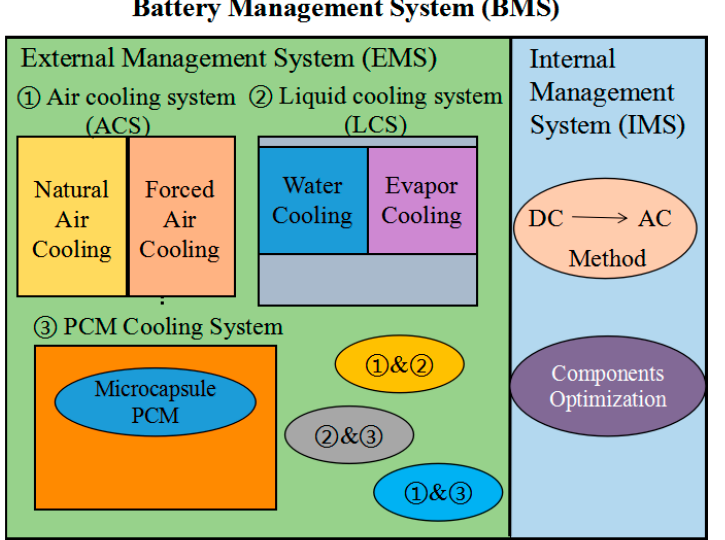
Figure 17. Summary of battery thermal management systems including the external management system (air cooling system, liquid cooling system, PCM cooling system) and the internal management system (alternating current, component optimization).